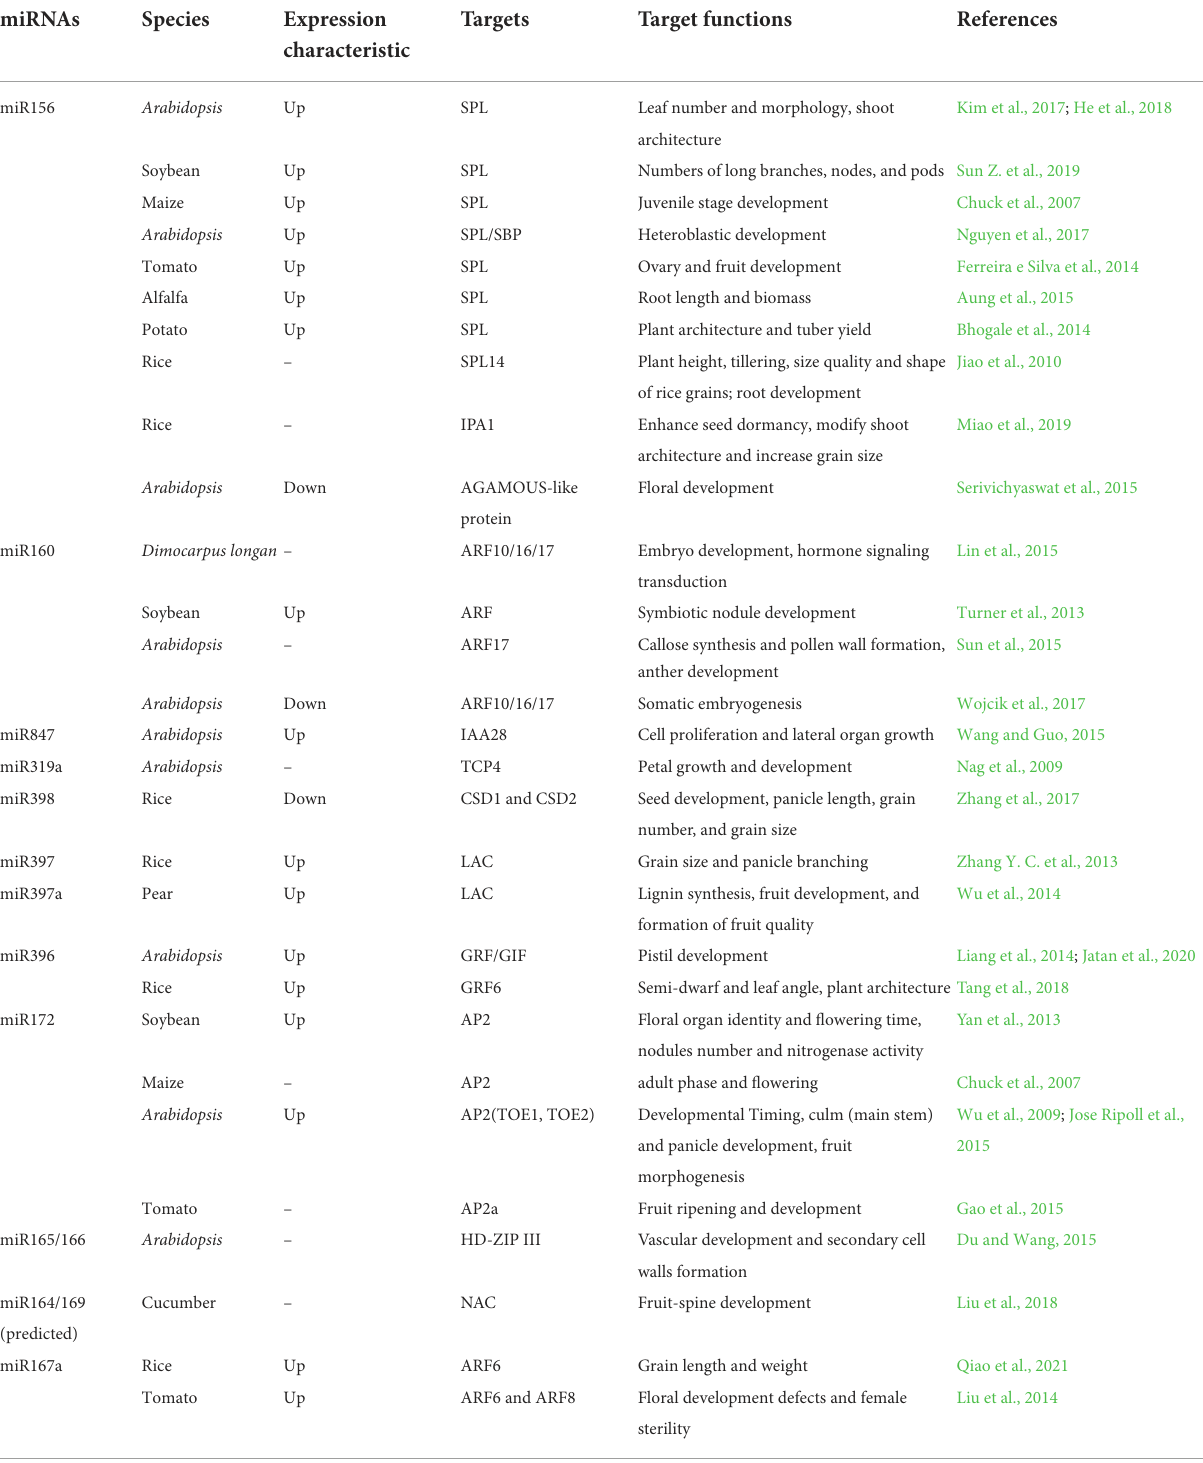
TABLE 1 A list of miRNAs and their targets are involved in the regulation of growth and development in various plants.